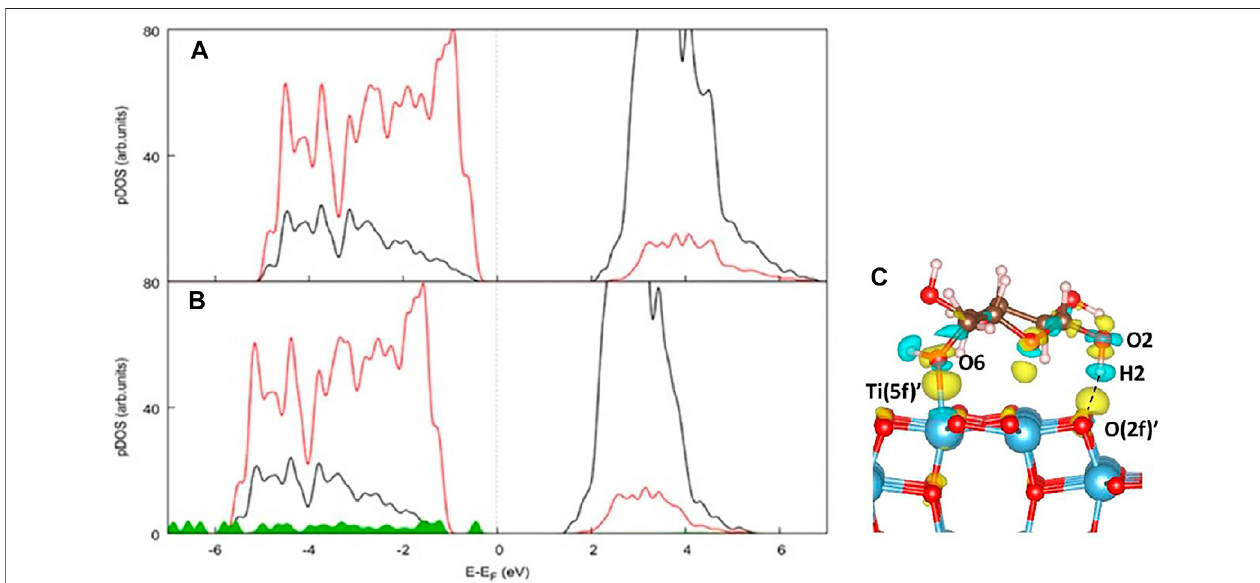
FIGURE 7 | Atom- and angular momentum-projected density of states (pDOS) of (A) the TiO 2 (100) surface and (B) the D -glucose-TiO 2 (100) system in the most stable con fi guration Ads_1 computed at the PBE + U-D3BJ level of theory. Color code: Ti d states black, O p states red, Glucose states green. (C) Charge density difference plot referred to Ads_1. Color code: yellow and cyan areas indicate an electron accumulation and depletion, respectively. The isosurface level is set to 0.003 eV/Å 3 .